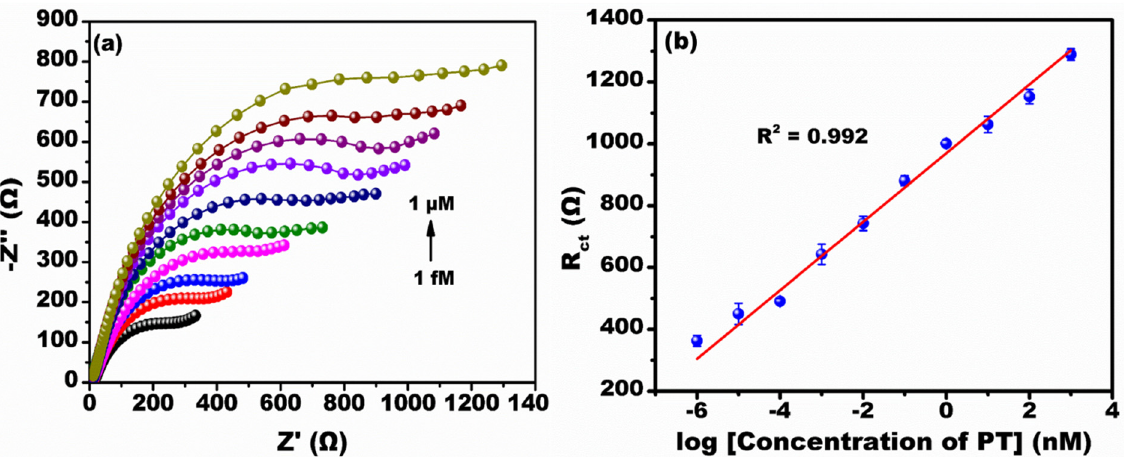
Figure 5. Electrochemical detection of PT by EIS. ( a ) Nyquist spectra at various concentrations (1 fM to 1 µM) of PT; ( b ) The calibration plot at various log concentrations of PT.